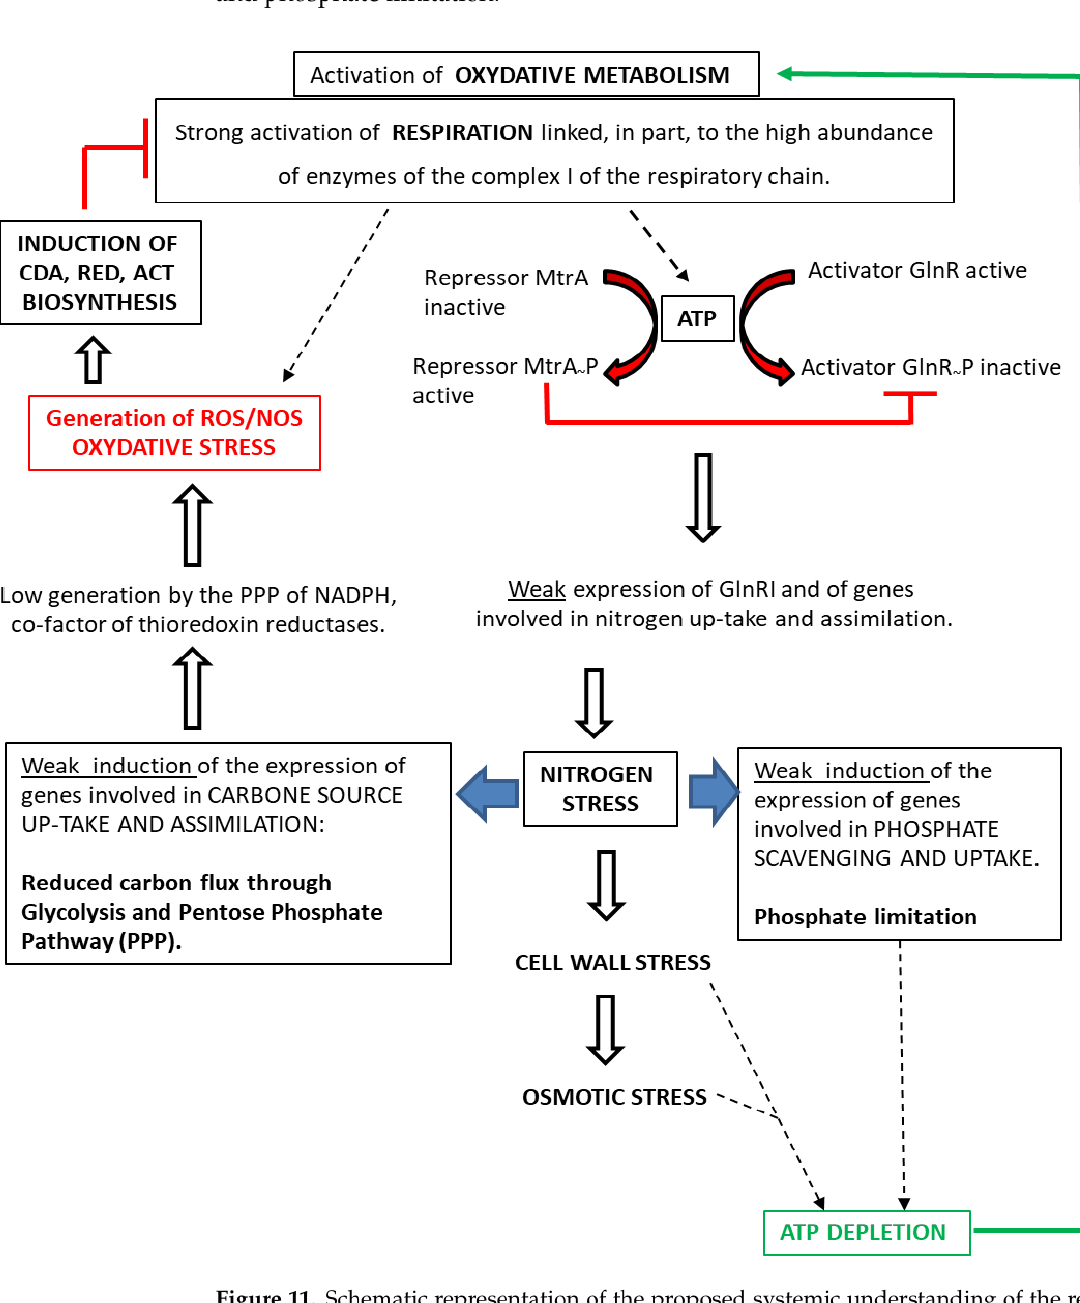
Figure 11. Schematic representation of the proposed systemic understanding of the relationships between specific physiological and metabolic features of SC and antibiotics production.